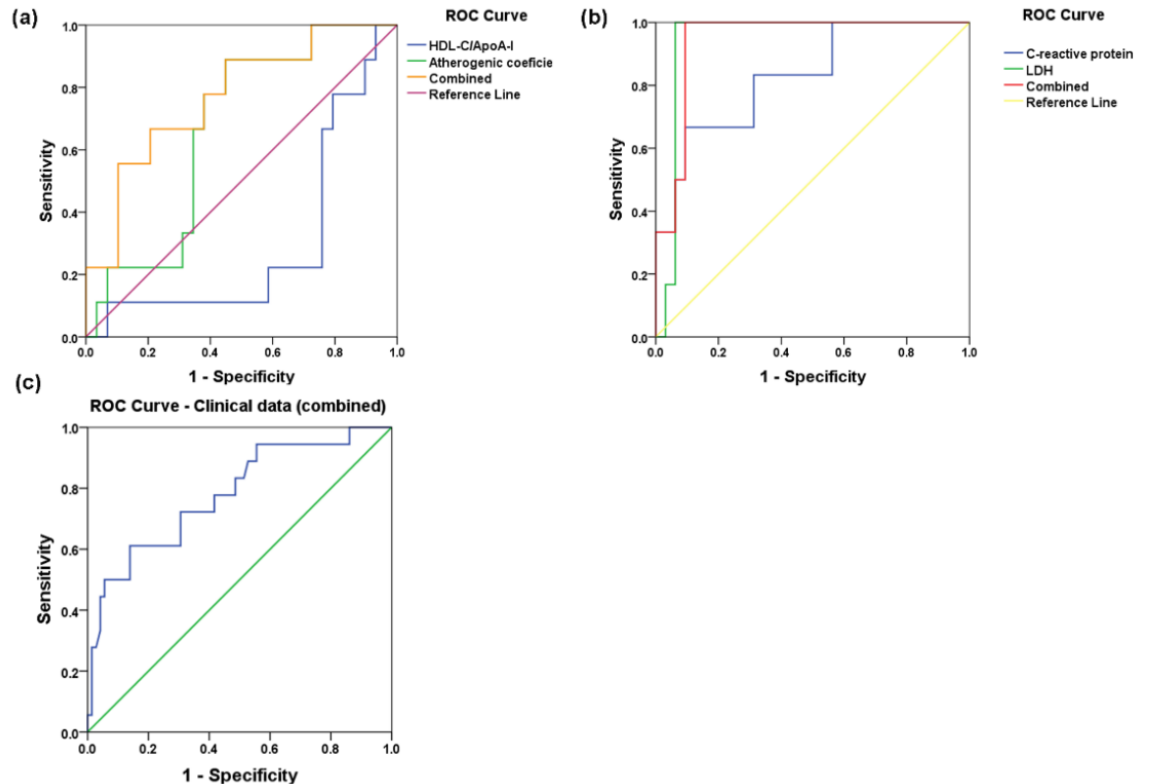
Figure 7. Receiver operating characteristic (ROC) curves for the predictive potential of univariate and multivariate models for follow-up major adverse cardiovascular events (MACE) using: ( a ) HDL-C/apoA-I ratio and atherogenic coefficient (non-HDL-C/HDL-C), ( b ) C-reactive protein (CRP) and lactate-dehydrogenase (LDH) levels, and ( c ) clinical data, plasma values being measured at hospital discharge (T 1 ) in plasma from ST-elevation myocardial infarction (STEMI) patients. All diagonal lines are for AUC = 0.5.